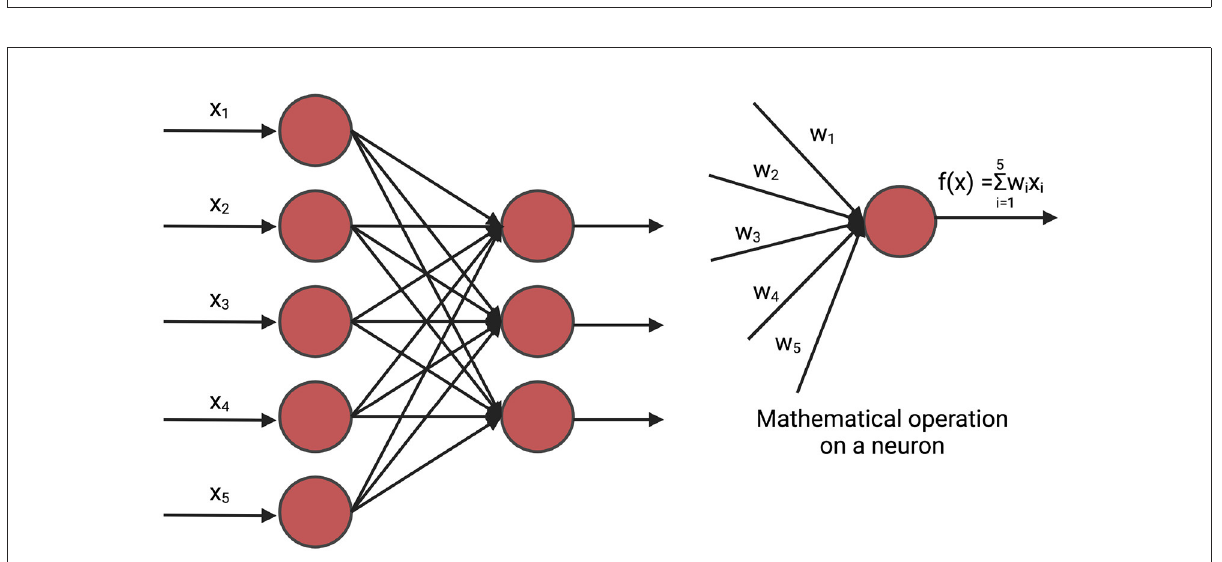
FIGURE2 An example of fully connected layer. x i is the input and w i is the weight. The weights are initialized randomly and are optimized iteratively for prediction. In GS, x i is the